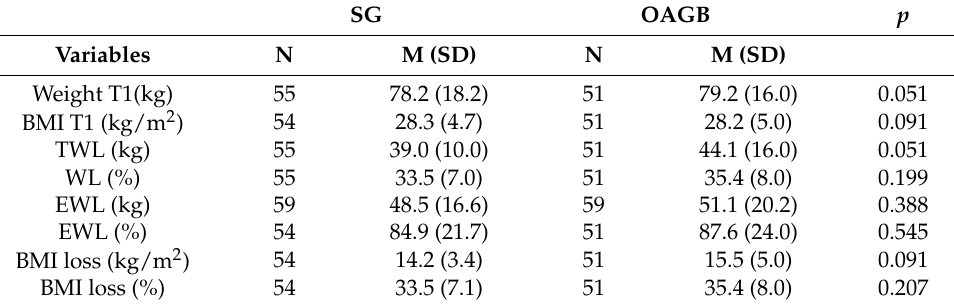
Table 3. Weight and BMI trends one year after surgery, T1